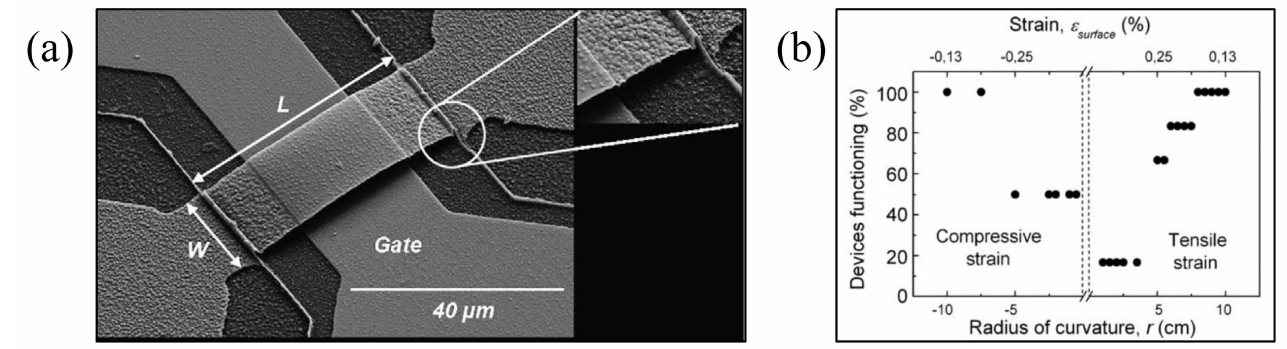
Figure 2. ( a ) Thin-film silicon beam on a PET film [48] Reprinted/adapted with permission from Ref. [48]. 2008, Elsevier. ( b ) Influence of substrate bending on device function [48] Reprinted/adapted with permission from Ref. [48]. 2008,